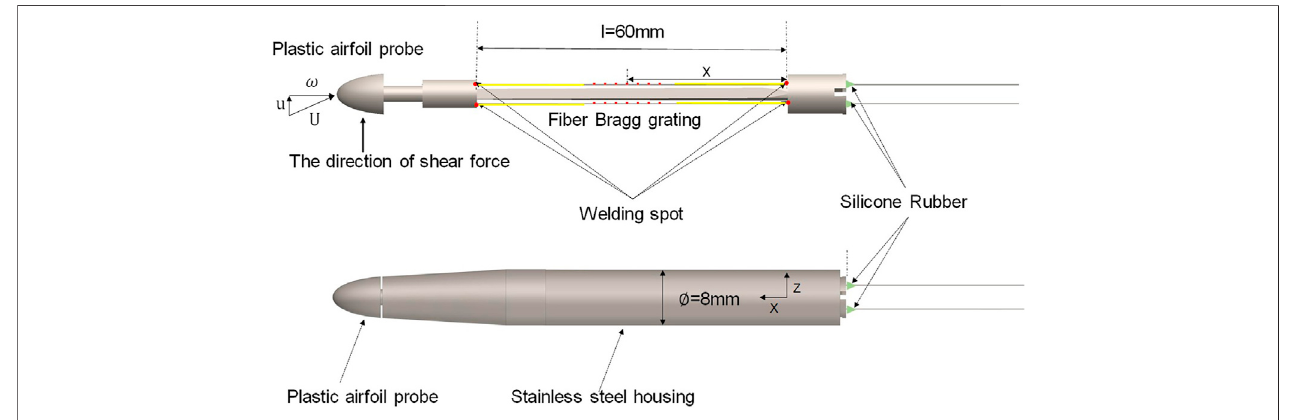
FIGURE 14 | Package structure diagram of the sensor